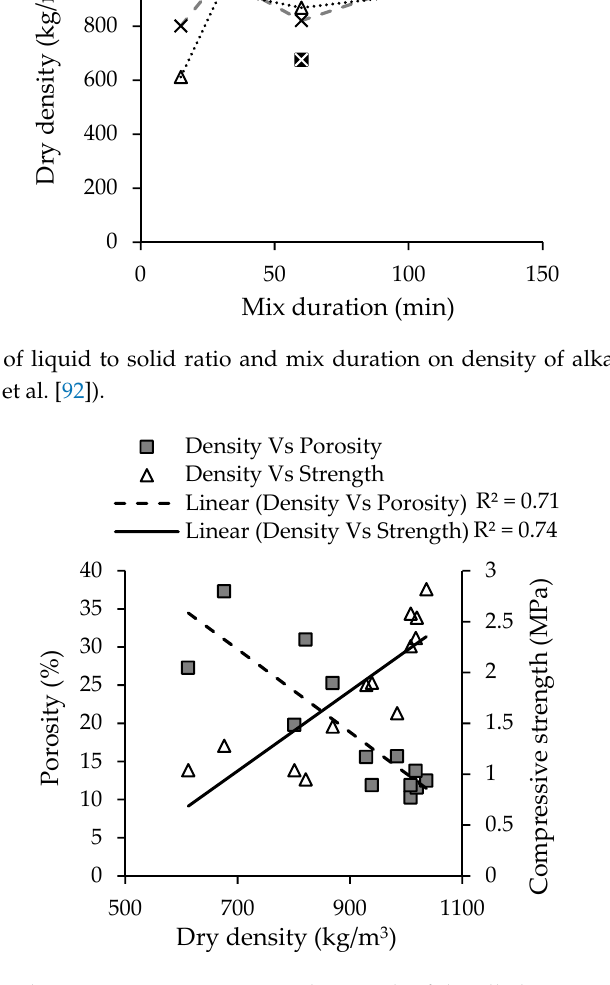
Figure 9. Relationship between microstructure and strength of the alkali-activated MIBA (adapted from Chen et al. [92]).